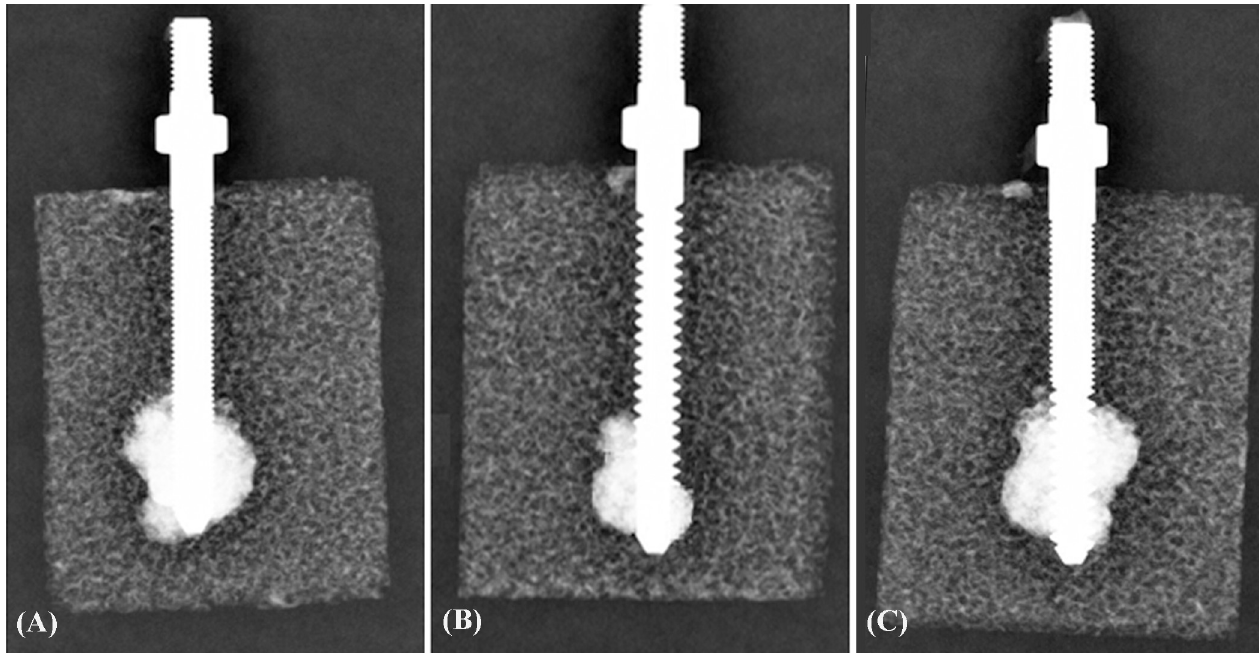
Fig 5. Radiological images showing test blocks and the inserted cannulated screws following cement injection. (A) SFT; (B) SCT; and (C) DC/DT. The radiological examinations indicated that the cement was exuded from the radial holes in the flow path.